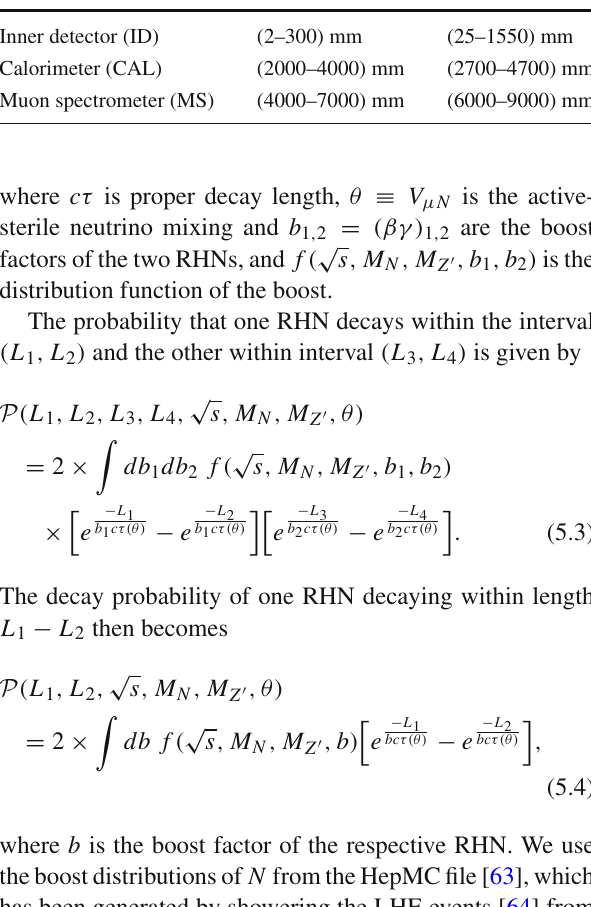
Table 1 Coverage of geometric acceptance of various sub-detectors of the HL-LHC and FCC-hh Detector